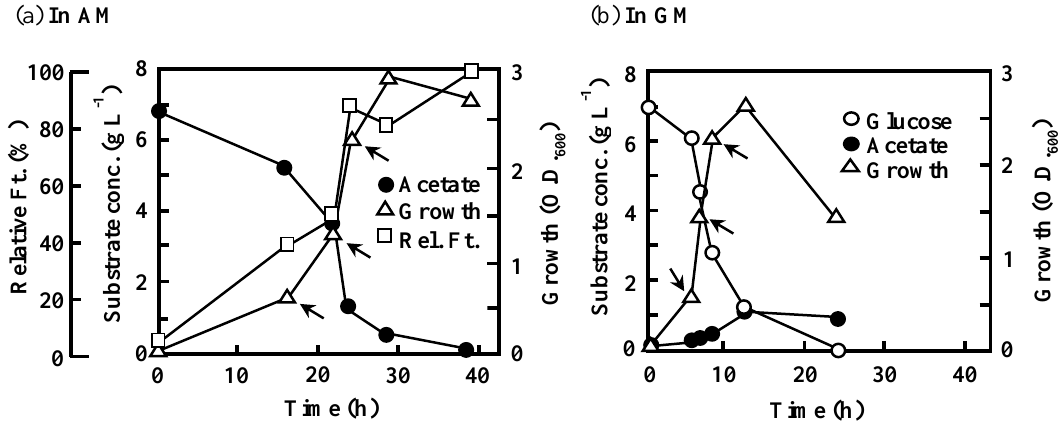
Figure 8. Changes in substrate concentration, growth, and relative flocculation activity (flocculation titer, Ft) during the batch cultivation of C. freundii IFO 13545 in: AM ( a ); and GM ( b ). Arrows indicate the sampling points of the cultures for qRT-PCR analysis (early-, mid-, and late-log phases in Figure 9).